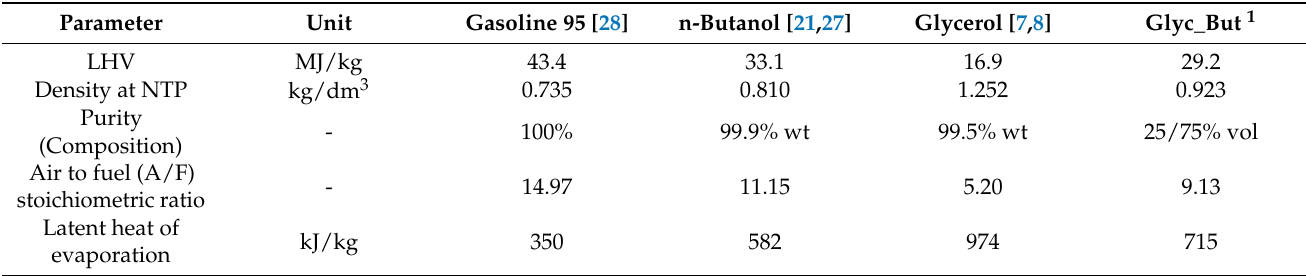
Table 2. Fuel applied for the research work and its physical properties [7,8,21,27,28]. Parameter Unit